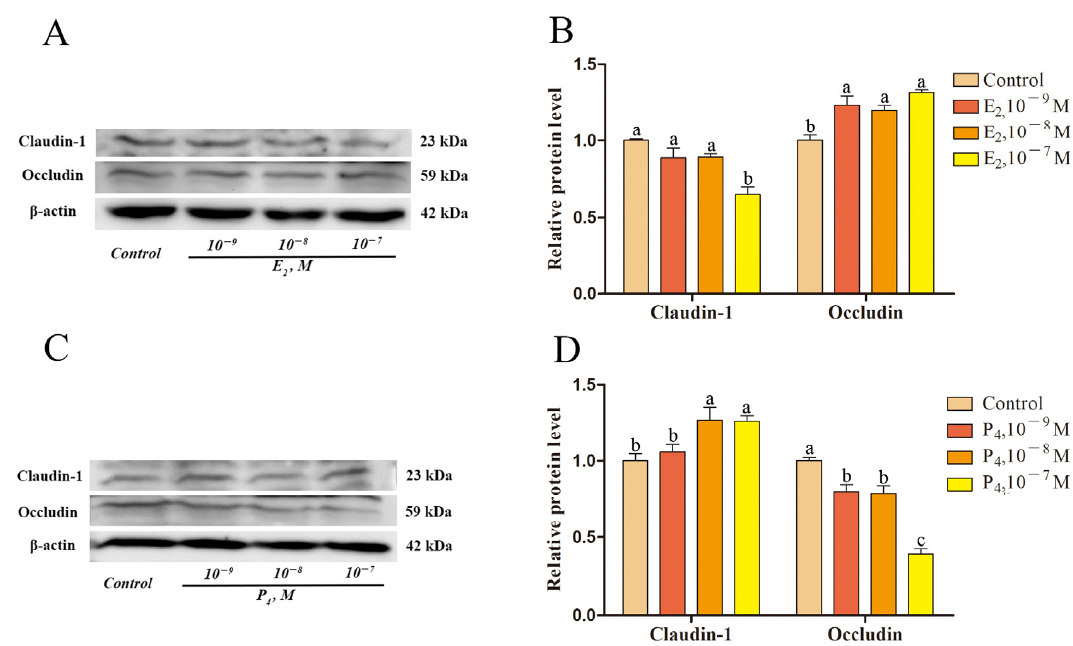
Figure 7. Effects of E 2 and P 4 on the relative protein expression levels of claudin-1 and occludin in epithelial cells. ( A ) Western blotting of E 2 treatment. ( B ) Relative protein expression for E 2 treatment. ( C ) Western blotting of P 4 treatment. ( D ) Relative protein expression for P 4 treatment. Different lowercase letters indicate a significant difference at p < 0.05. E 2 , 17 β -estradiol; P 4 progesterone. Concentration is measured in mol/L.